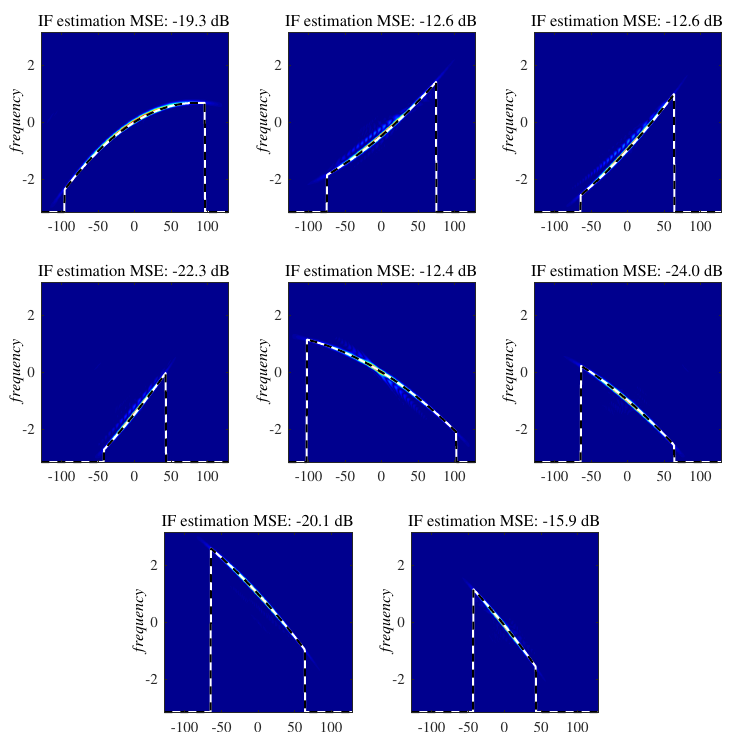
Figure 10. Instantaneous frequency estimation for individual signal components based on the extracted signal components (dashed black) and the original signal components (solid white). MSEs between the two IF estimates is provided for each component of the signal from Example 2. The noise variance is σ 2 ε = 0.1. Decomposition is based on C = 128